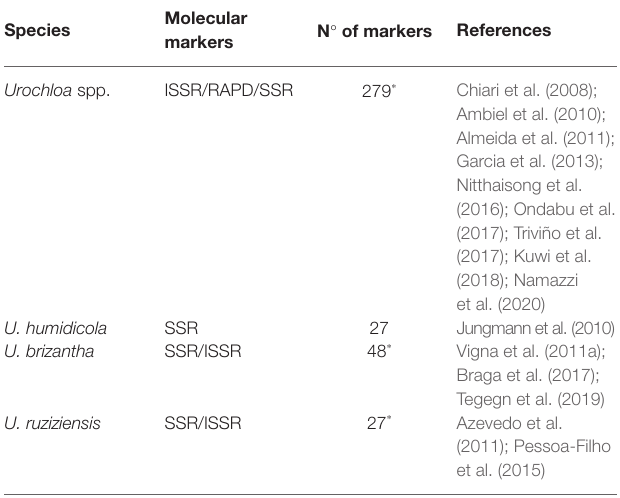
TABLE 3 | Main studies of the genetic diversity of Urochloa spp. using molecular markers. Molecular Species markers